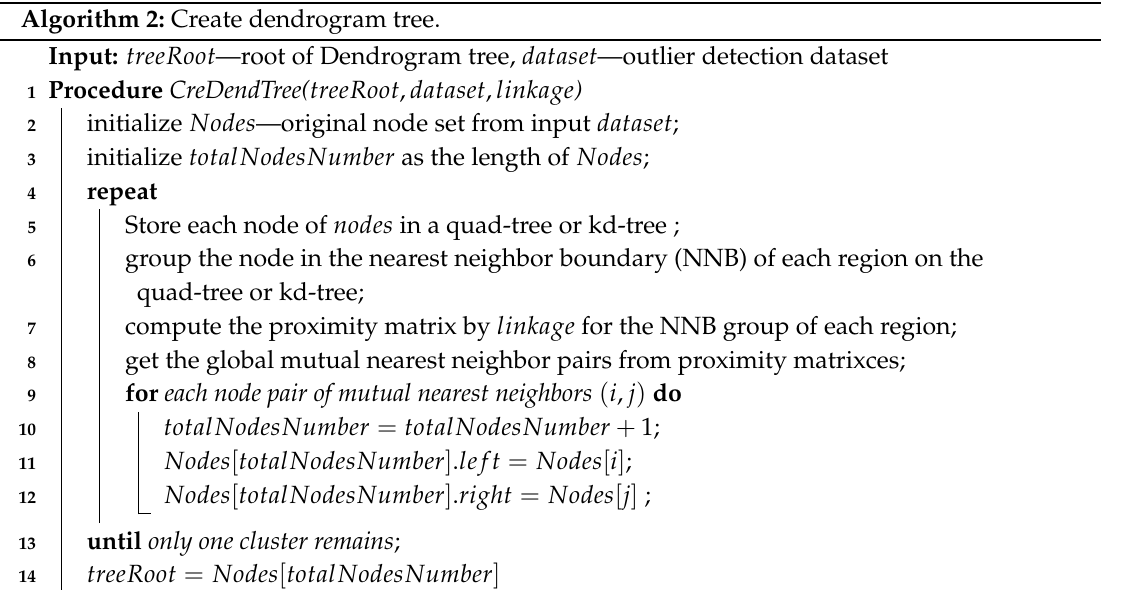
Algorithm 2: Create dendrogram